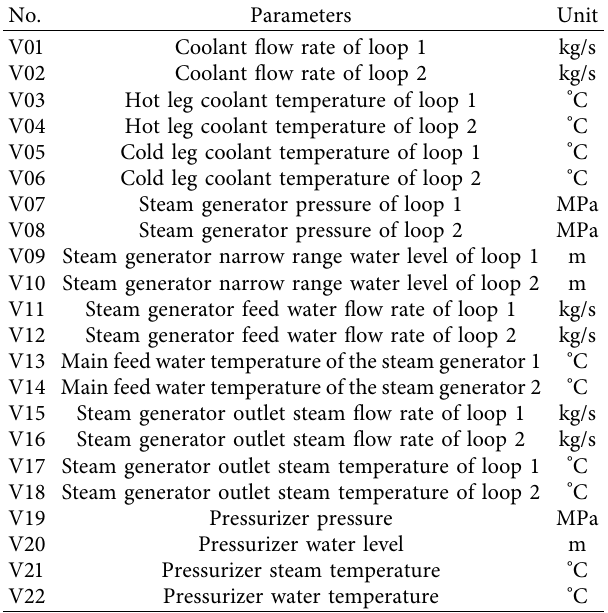
Table 1: Te monitoring parameters used in the training and testing of the proposed prediction model.